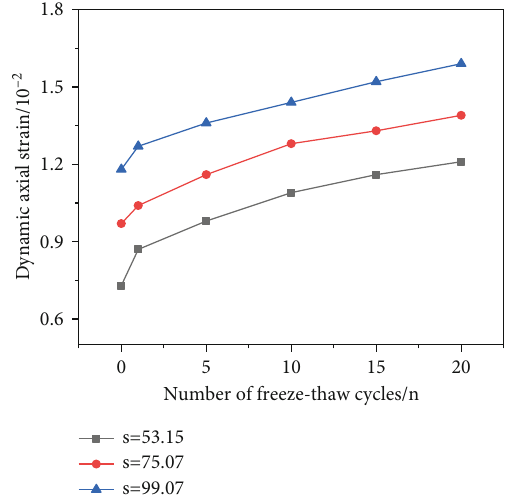
Figure 5: Dynamic compressive strength of sandstone under di ff erent freeze-thaw cycles.